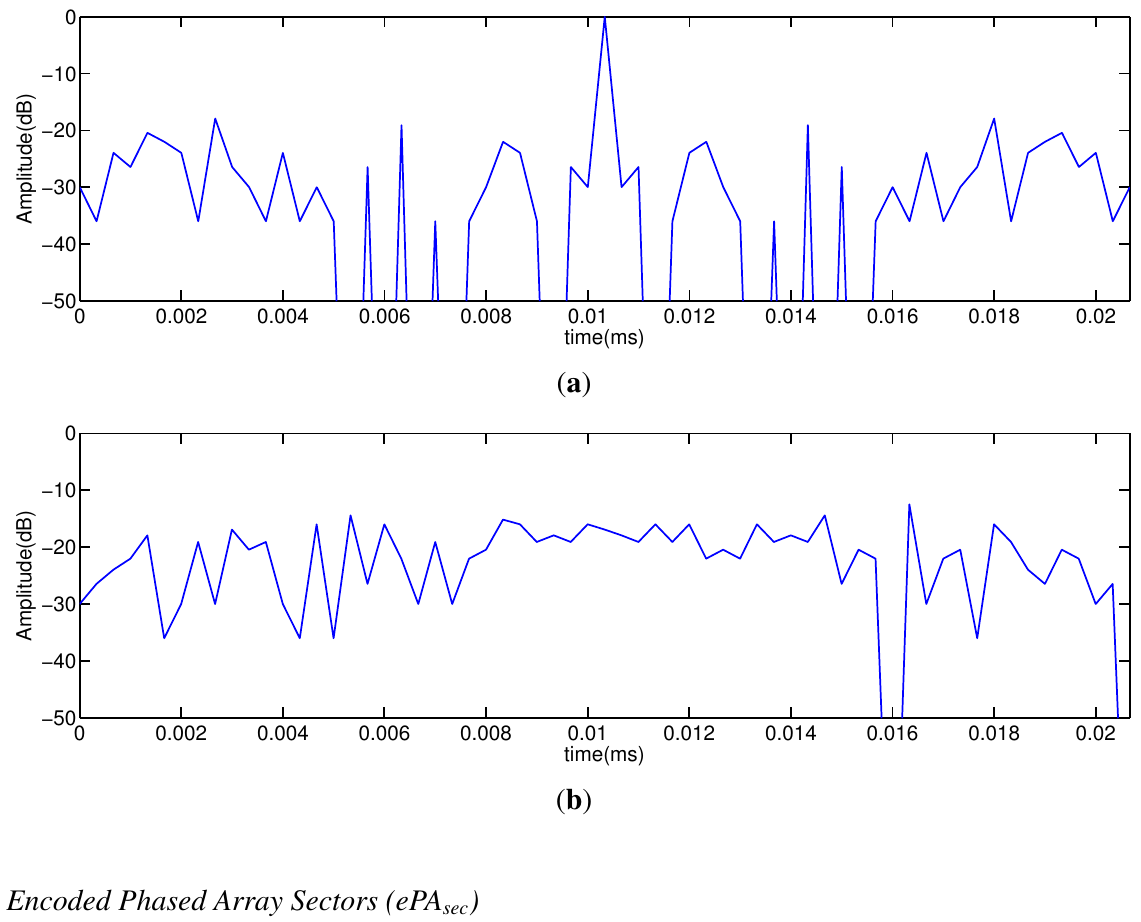
Figure 1. ( a ) Auto-correlation (AC) and ( b ) cross-correlation (CC) functions of a Kasami sequence with L = 63 bits modulated in BPSK (binary phase shift keying) using a single carrier period per